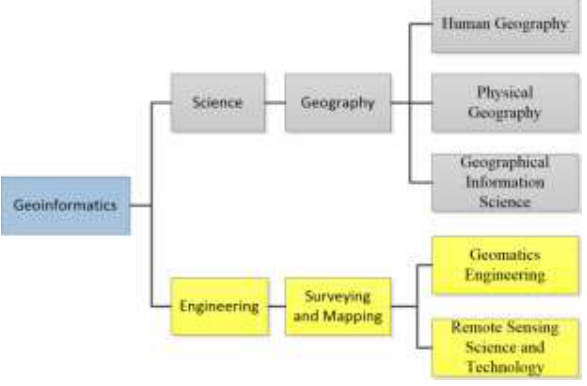
Figure 1. Undergraduate education in